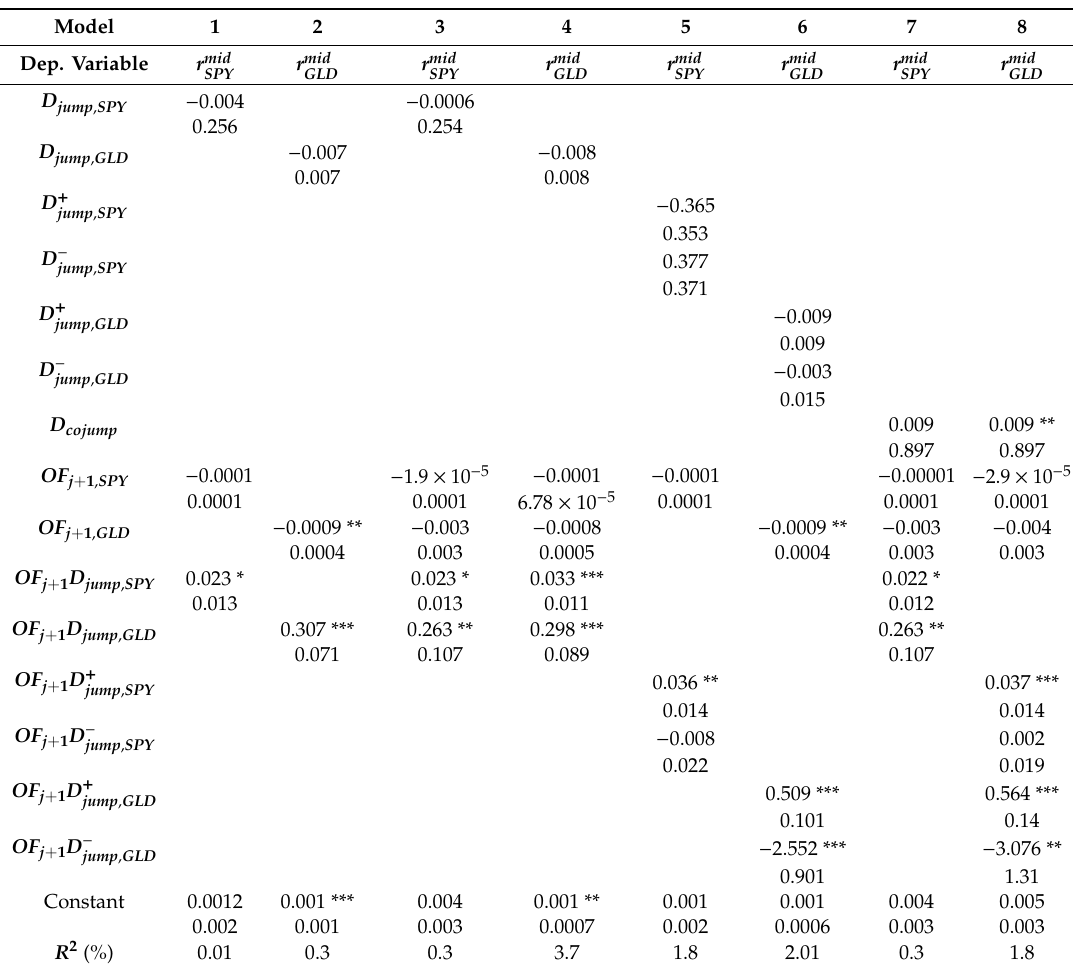
Table 6. Jumps and price